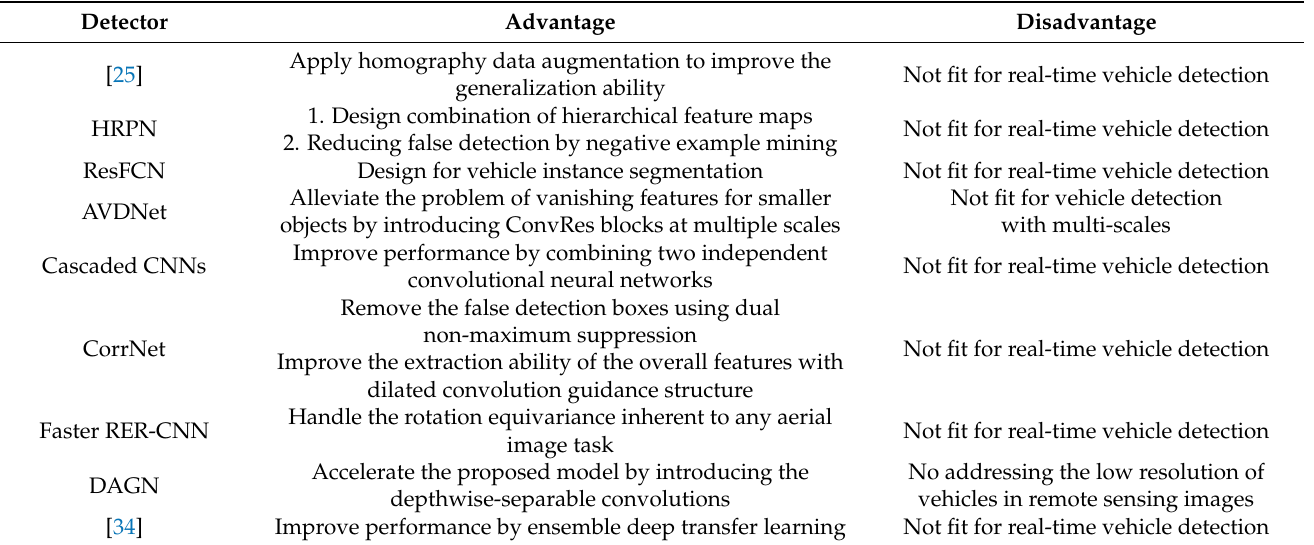
Table 1. Comparison of different vehicle